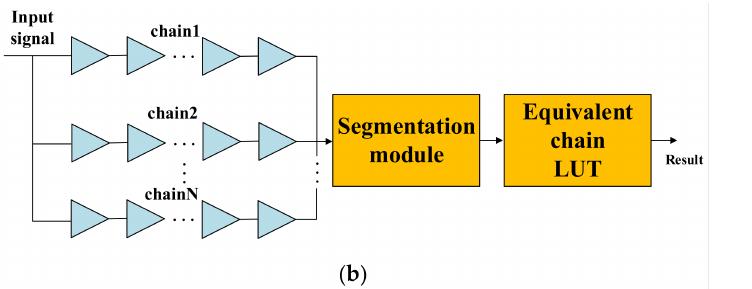
Figure 14. Block diagram ( a ) multichain measurements averaging; ( b ) multichain cross